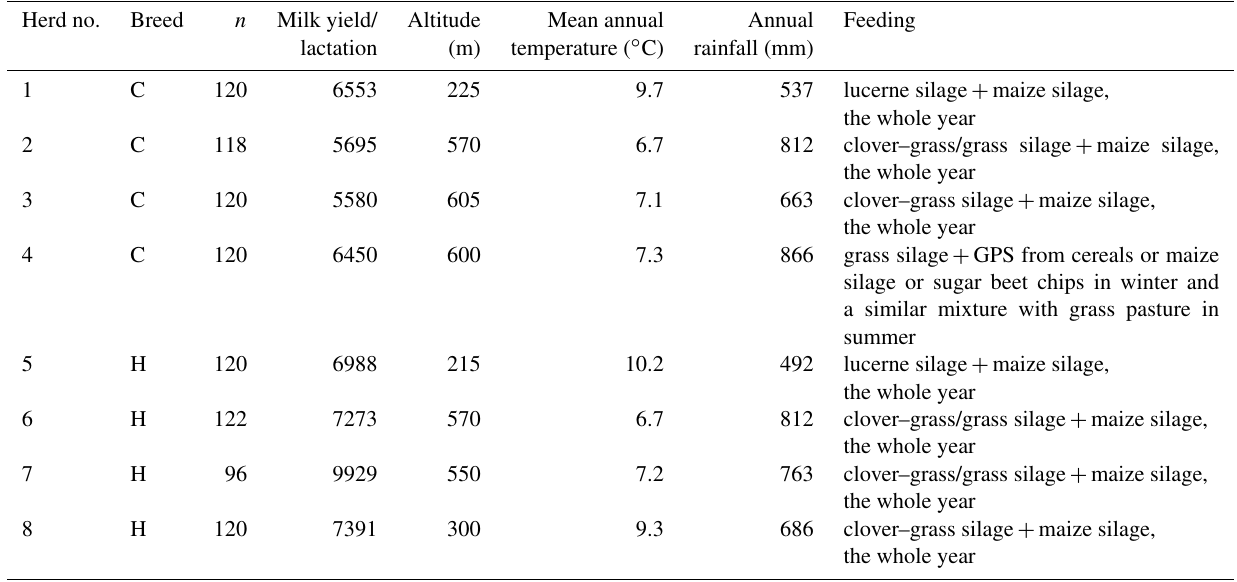
Table 1. Basic information about dairy herds and their environment and feeding. Herd